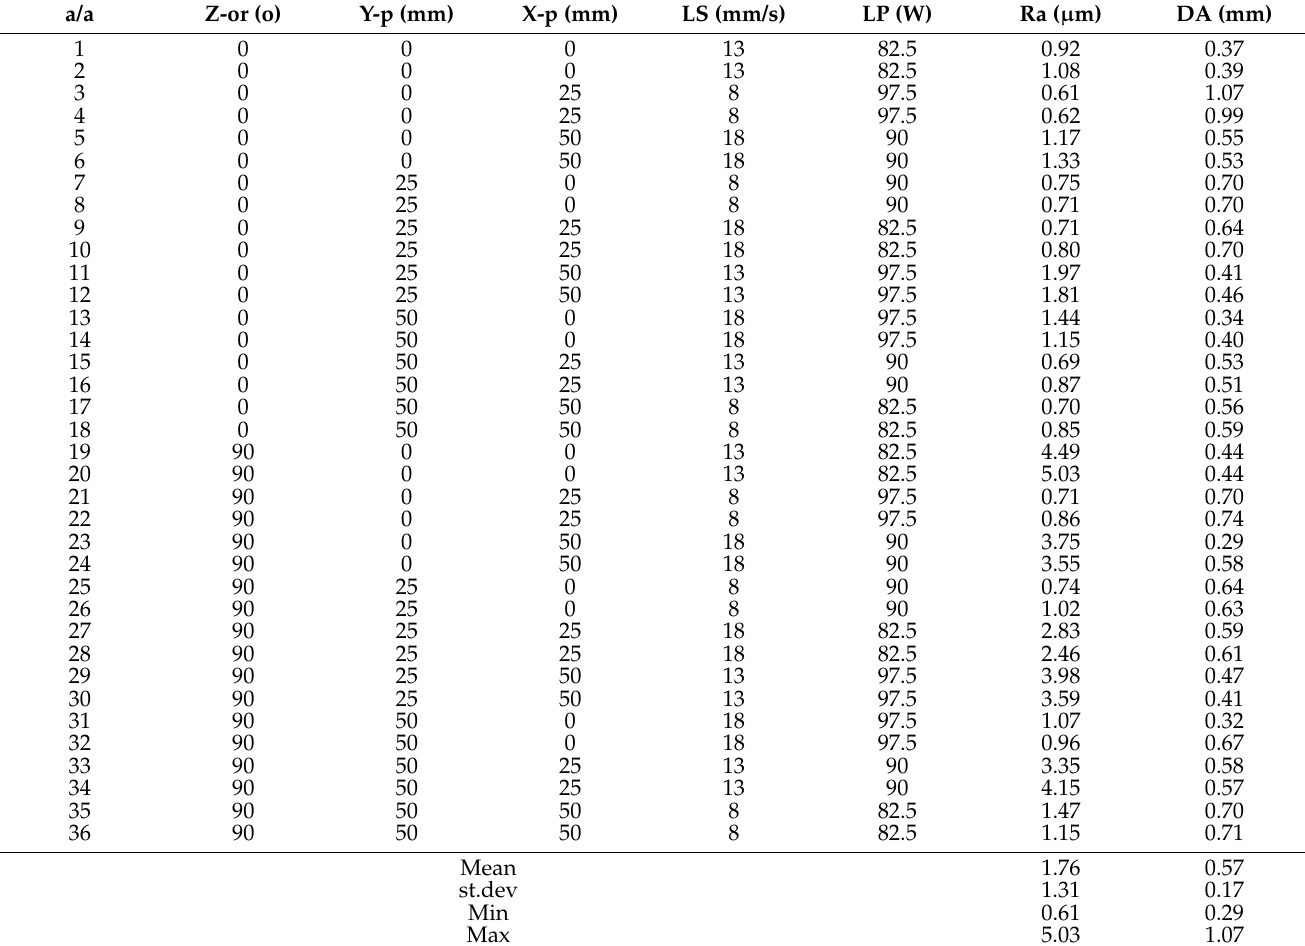
Table 2. Parameter combinations and experimental